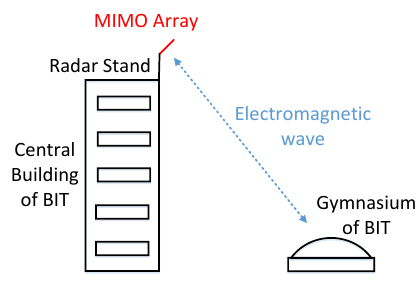
Figure 18. Geometry of this experiment.